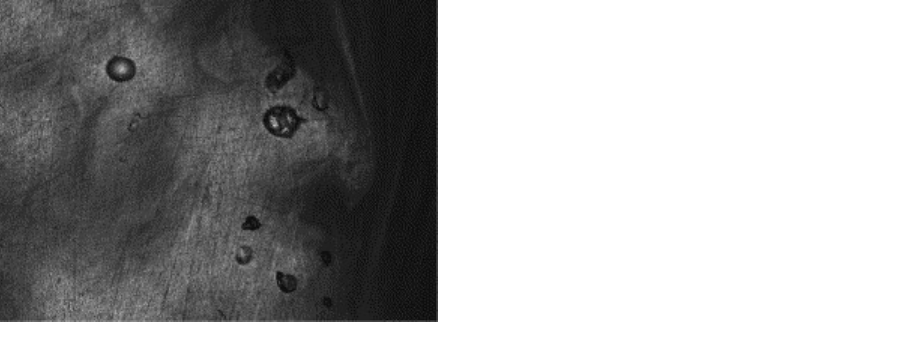
Figure 11. Maximum strength 23 °C for various mold temperatures and for various polymerization times. Dry as-molded properties. Reprinted from Reference [8], under open-access license. 5.2.9. Thermal Interaction between Fiber and Matrix The addition of a volumetric percentage of fibers has a significant effect on heat trans- fer during the infusion process. The presence of reinforcement facilitates the in-crease of the reaction speed by reducing the time available for the infusion. This is because the fi- bers placed inside the mold are preheated together with it, and, therefore, the resin that propagates inside them during the infusion will heat up faster, since the total conductivity is increased thanks to the presence of the fibers [44]. Figure 12 shows the drop in the temperature gradient inside the mold that occurs immediately after the start of the infusion.